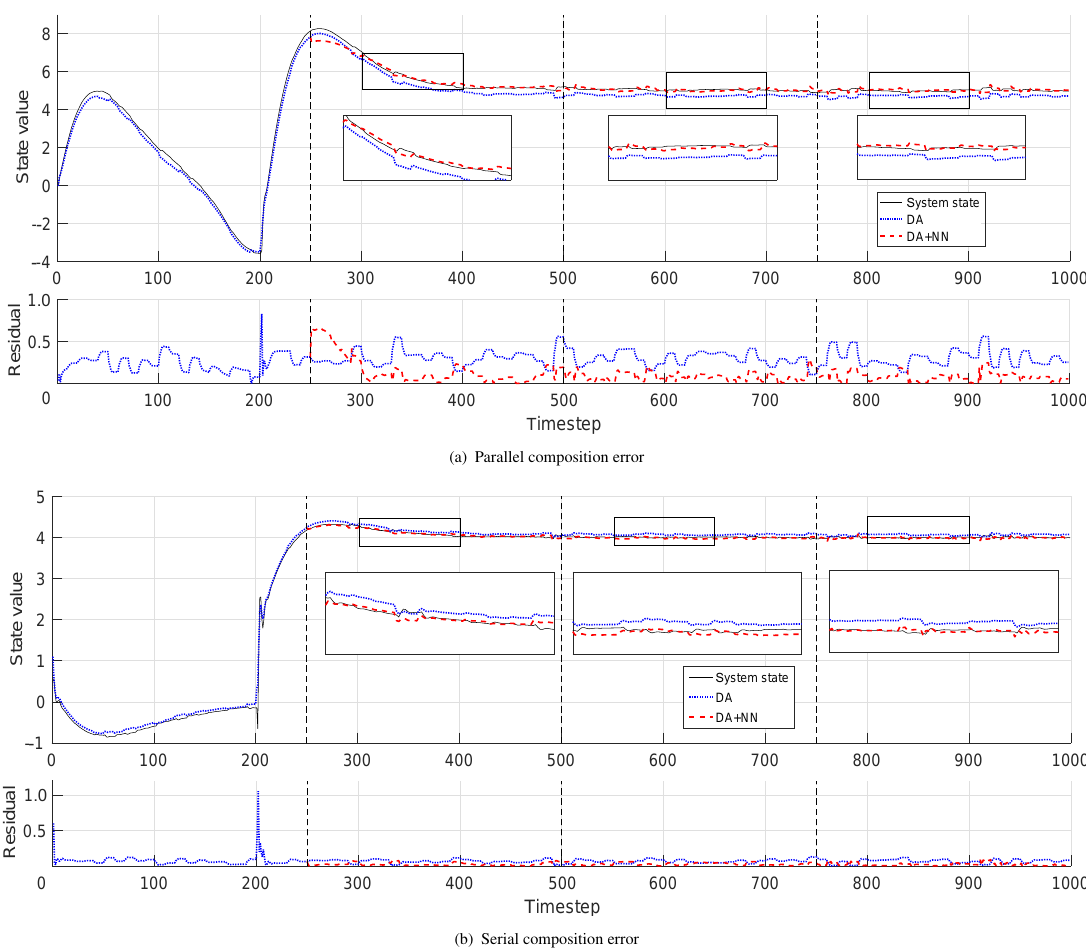
Fig. 3 Simulation result of DA+NN on double-integral system. The vertical dash-lines refer to the training